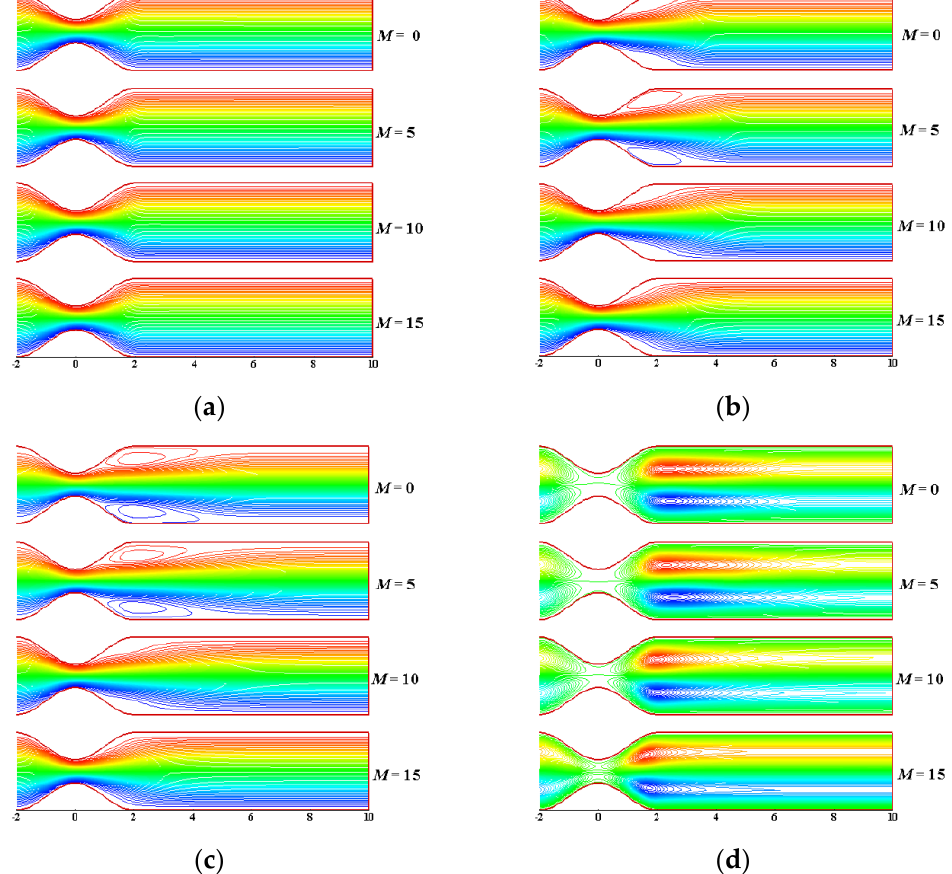
Figure 10. Streamlines of the pulsatile flow for different values of M with St = 0.02, Re = 700, and K = 0.6 at ( a ) t = 0, ( b ) t = 0.25, ( c ) t = 0.50, and ( d ) t = 0.75 .